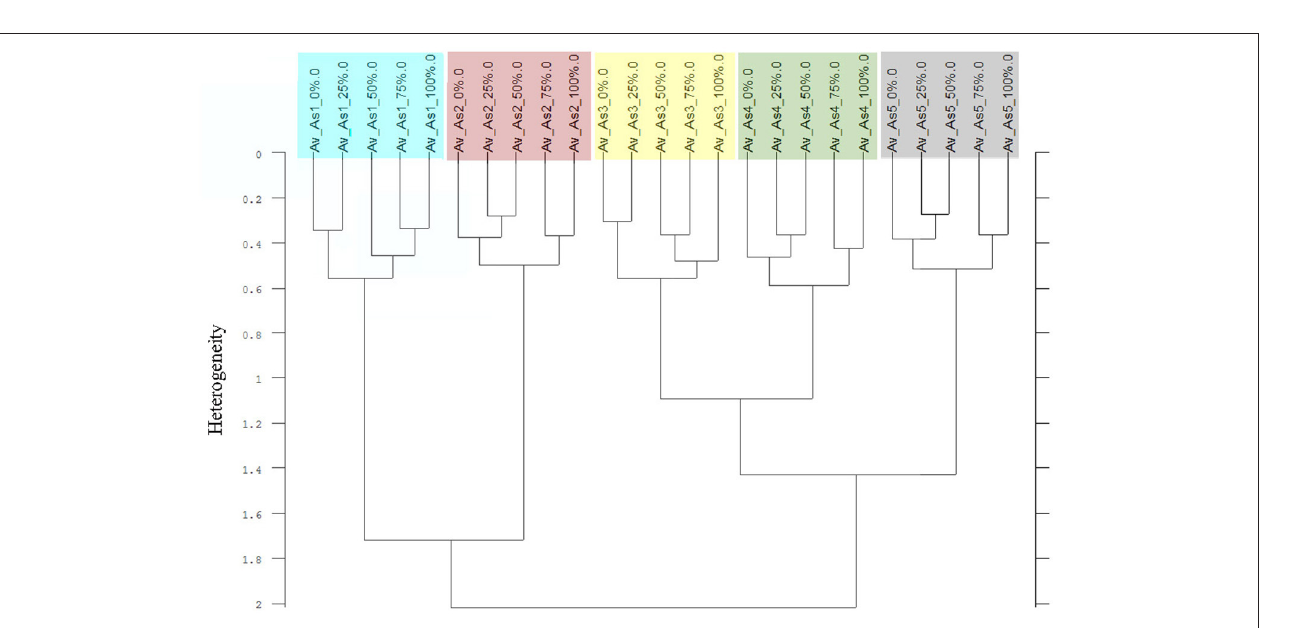
cell walls of five monocotyledonous species by chemical and chromatographic analyses and found species specific